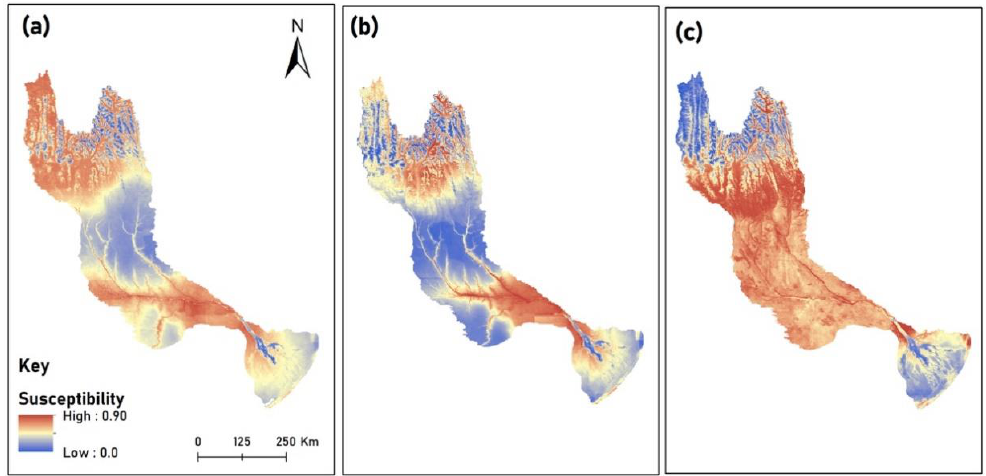
Figure 3. The map shows the LULC change susceptibility maps for different LULC change transitions were; ( a ) transition from natural to artificial, ( b ) transition from artificial to natural, ( c ) transition from natural-to-natural classes.